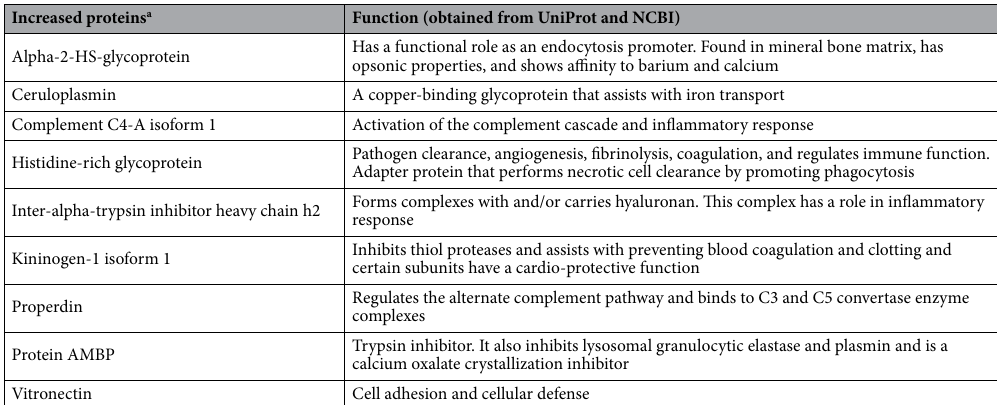
Table 2. Functions of a select group of increased proteins identified in the IRL group. a Proteins were selected that had average ratios >